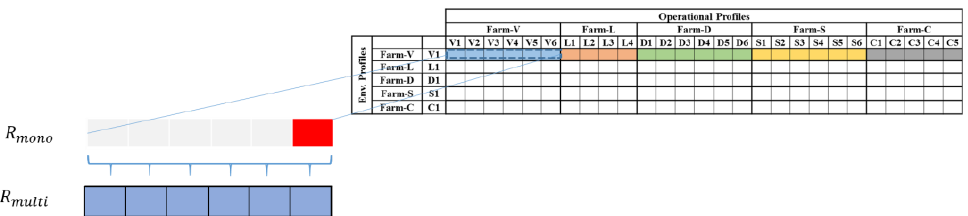
Figure 6. Multi-turbine visualization using Simulation Matrix; wind farms highlighted in color. The red box identifies induced fault in each turbine and the resulting 𝑅 𝑚𝑢𝑙𝑡𝑖 is shown.